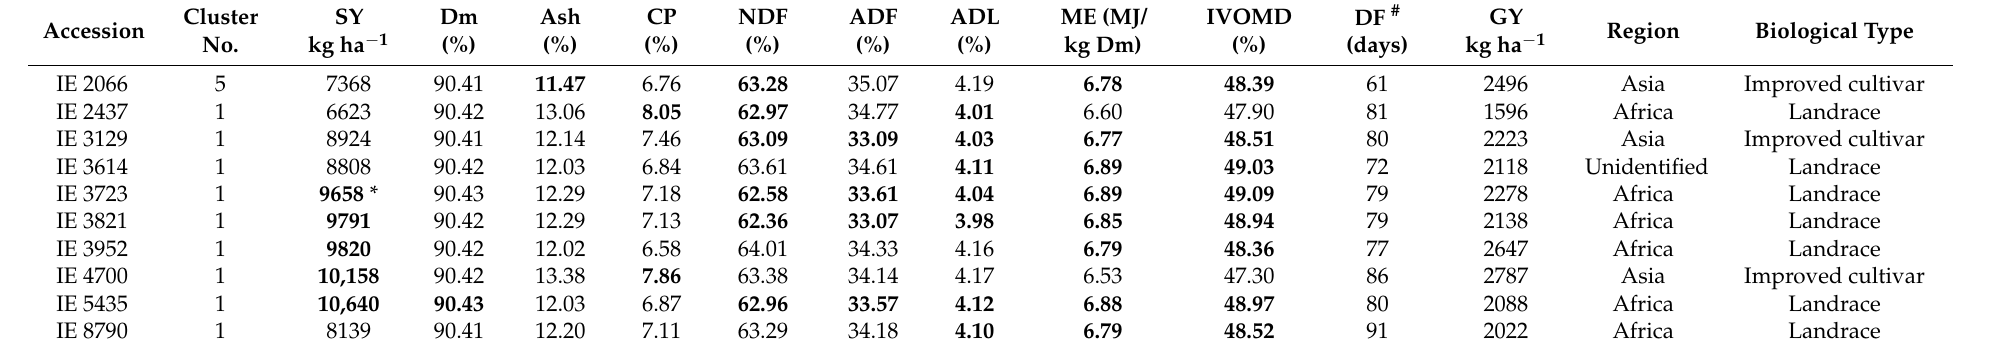
Table 8. Finger millet accessions with desirable multiple forage quality